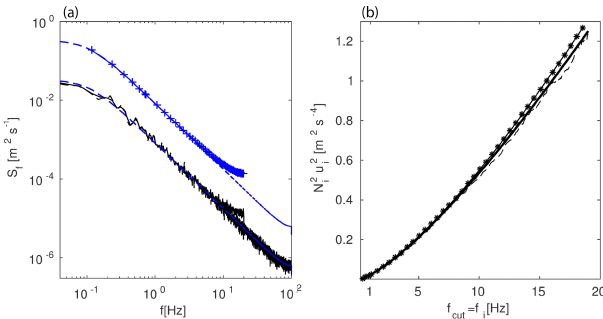
Figure 6. (a) Mean S(f ) profiles calculated from the simulation analysis: blue dashed lines – synthetic signal sampled with 200Hz; blue line with symbols – synthetic signal sampled with 40Hz; black lines – profiles from a single signal with u (cid:48) 2 = 0 . 0885ms − 1 . u 2 (b) Corresponding averaged N 2 profiles: solid line – 200Hz sig- i i nal; line with symbols – 40Hz signal; thin black line – profile from a single signal with u (cid:48) 2 = 0 . 28ms − 1 .